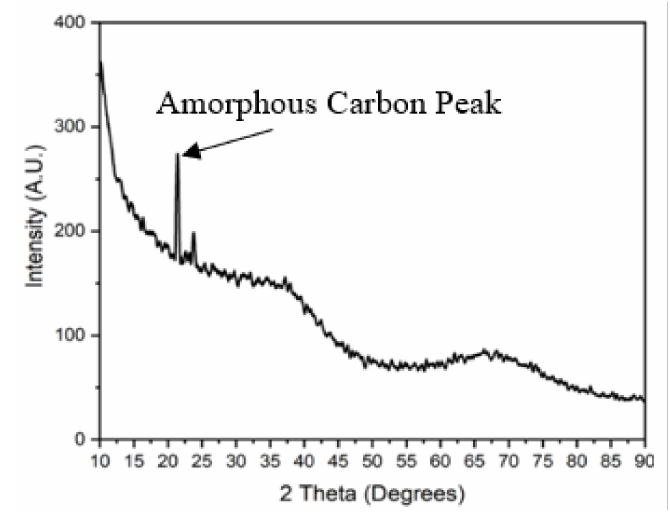
Figure 3. XRD patterns of PDC-SiCN ceramics at 1000 ◦ C.